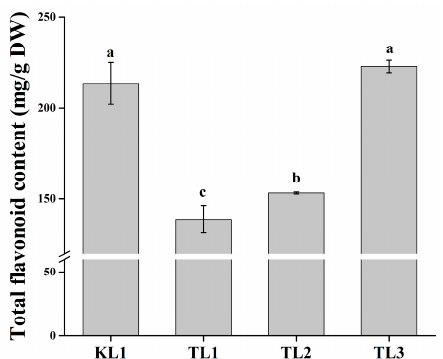
Figure 1. Total flavonoid content of tartary buckwheat and common buckwheat leaves. The lower-case letters above the histogram indicated the statistical significance at the level of 0.05 ( p < 0.05).